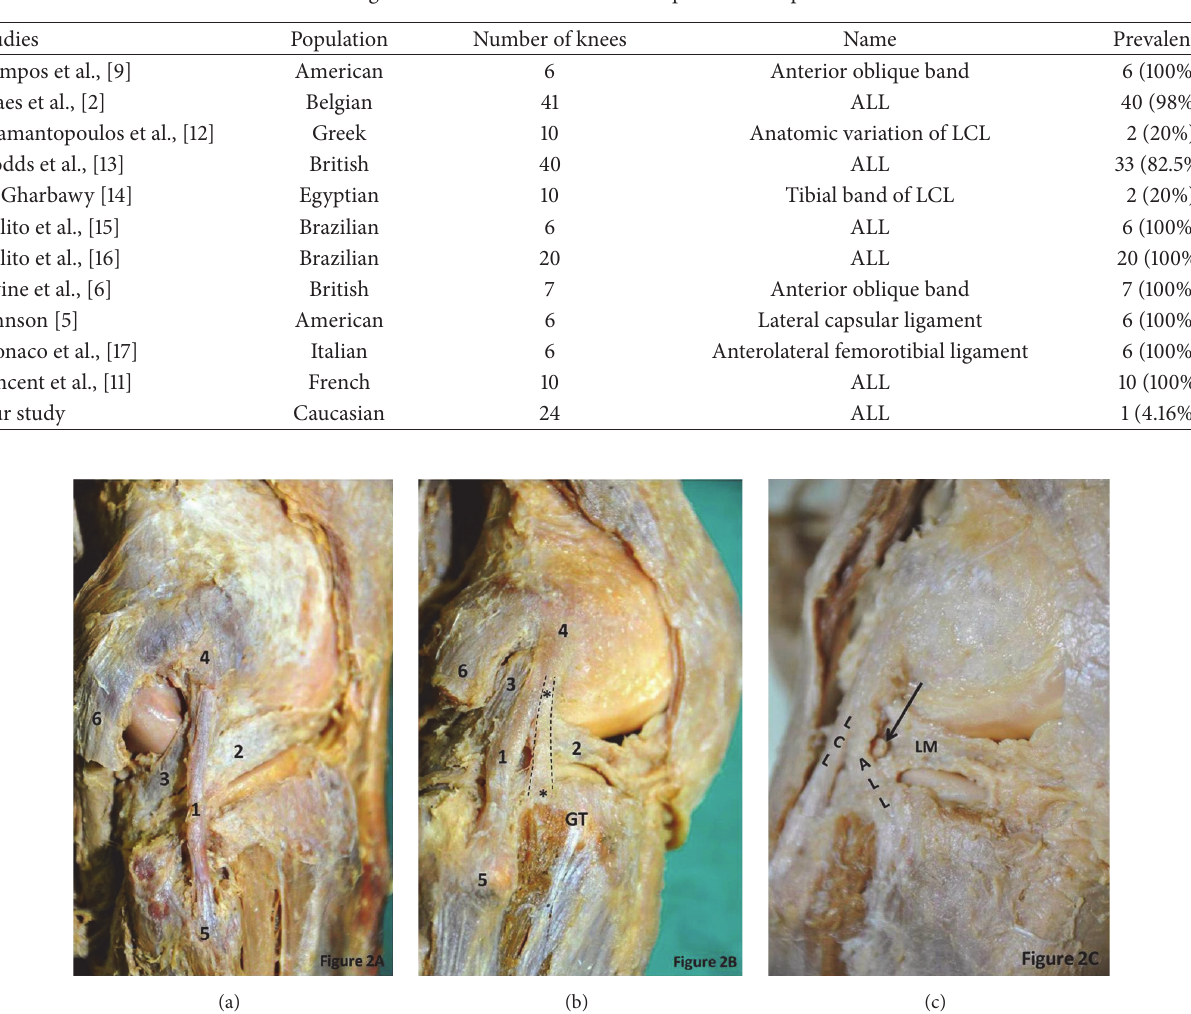
Figure 2: (a) Dissection of the right knee showing LCL with no ALL and its important relations on the lateral knee. 1: lateral collateral ligament; 2: lateral meniscus; 3: popliteus tendon; 4: lateral condyle of femur; 5: head of fibula; 6: lateral head of gastrocnemius; GT: Gerdy’s tubercle. (b) Dissection of the right knee showing ALL (taking its proximal bifurcation from LCL) and its important relations on the lateral knee. ∗ : anterolateral ligament; 1: lateral collateral ligament; 2: lateral meniscus; 3: popliteus tendon; 4: lateral condyle of femur; 5: head of fibula; 6: lateral head of gastrocnemius; GT: Gerdy’s tubercle. Dotted lines outline the extent of ALL. (c) Superficial dissection of right knee showing lateral geniculate vessels situated between ALL and LM. ALL: anterolateral ligament; LCL: lateral collateral ligament; LM: lateral meniscus. ∗ showing the lateral geniculate